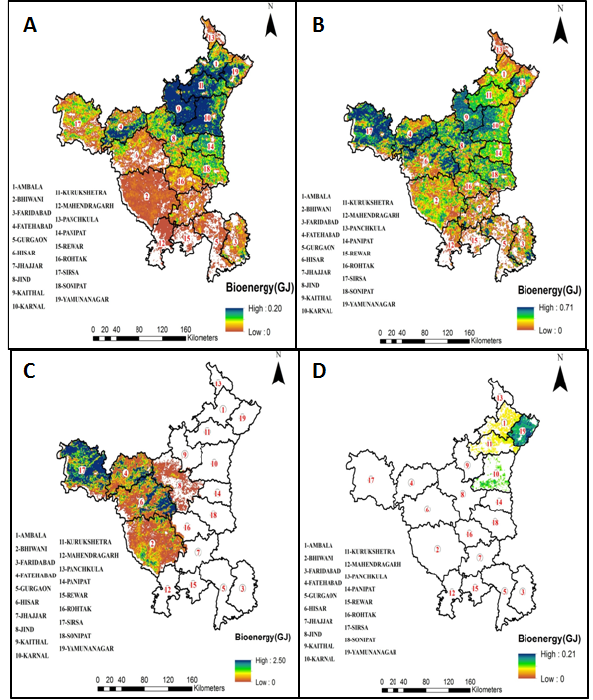
Fig. 3.3 Disaggregated bioenergy potential (GJ) of surplus residue potential of (A) Rice, (B) Wheat, (C) Cotton, (D) Sugarcane crop over